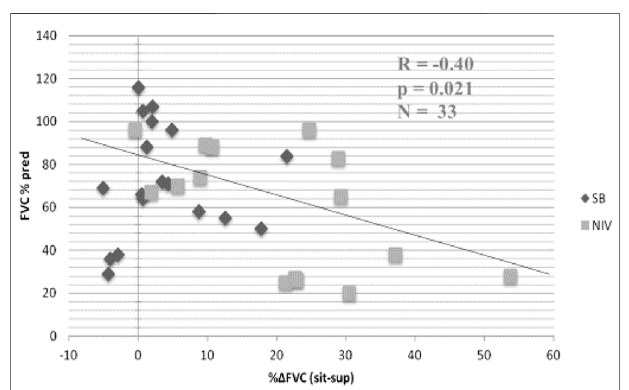
FIGURE 5 | Relationship between % change in forced vital capacity (FVC) from seated (sit) to supine (sup) posture and baseline FVC in seated position in patients with neuromuscular disease (FVCsit, % predicted). Black diamonds, spontaneous breathing (SB); grey squares, noninvasive ventilation (NIV). Patients withgreater than20%decrease inFVCwhen supine required NIV. From (Chen et al., 2013).